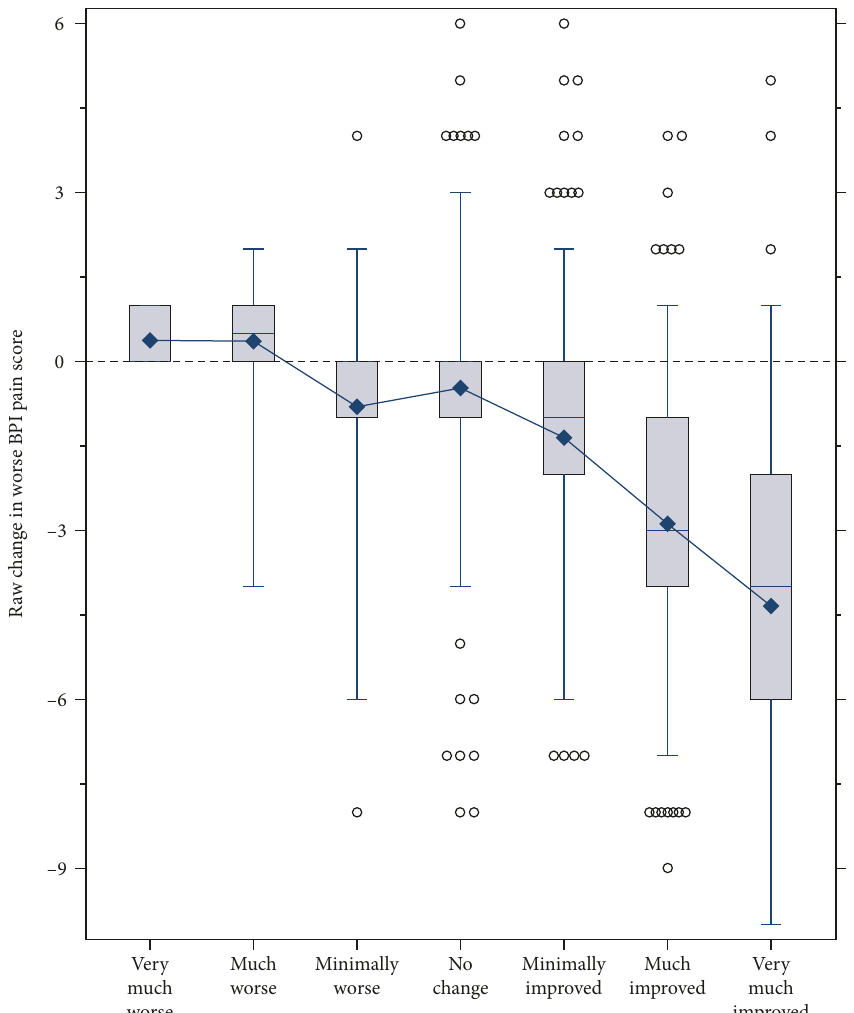
Figure 1: Box plot of raw change in the m-BPI score from the baseline to week 5/end of study by PGIC categories. The center line inside the box represents the median, the box’s hinges are the 25th and 75th percentile, the whiskers bound the central 95 percent of the distribution, the circles beyond the whiskers are outliers, and the diamond represents the mean. BPI, Brief Pain Inventory; m-BPI, modified Brief Pain Inventory; PGIC, patient global impression of